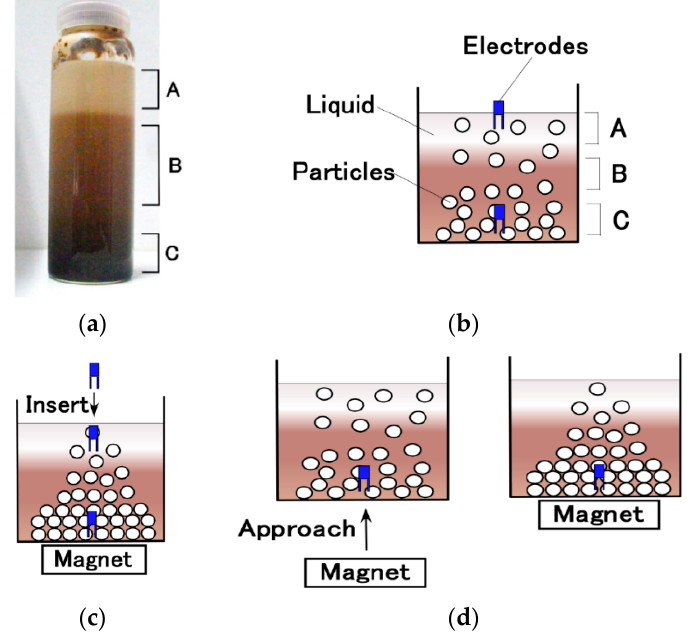
Figure 2. MCF rubber liquid in a rectangular container and the relation between the liquid and electrodes as shown in Figure 1 ( a ) Photograph of sedimentation of the MCF rubber liquid in the static condition; ( b ) the case without a magnet; ( c ) the case of a magnet installed underneath the container; ( d ) the case of electrodes placed at the bottom of the container beforehand and the magnet approaching the bottom of the